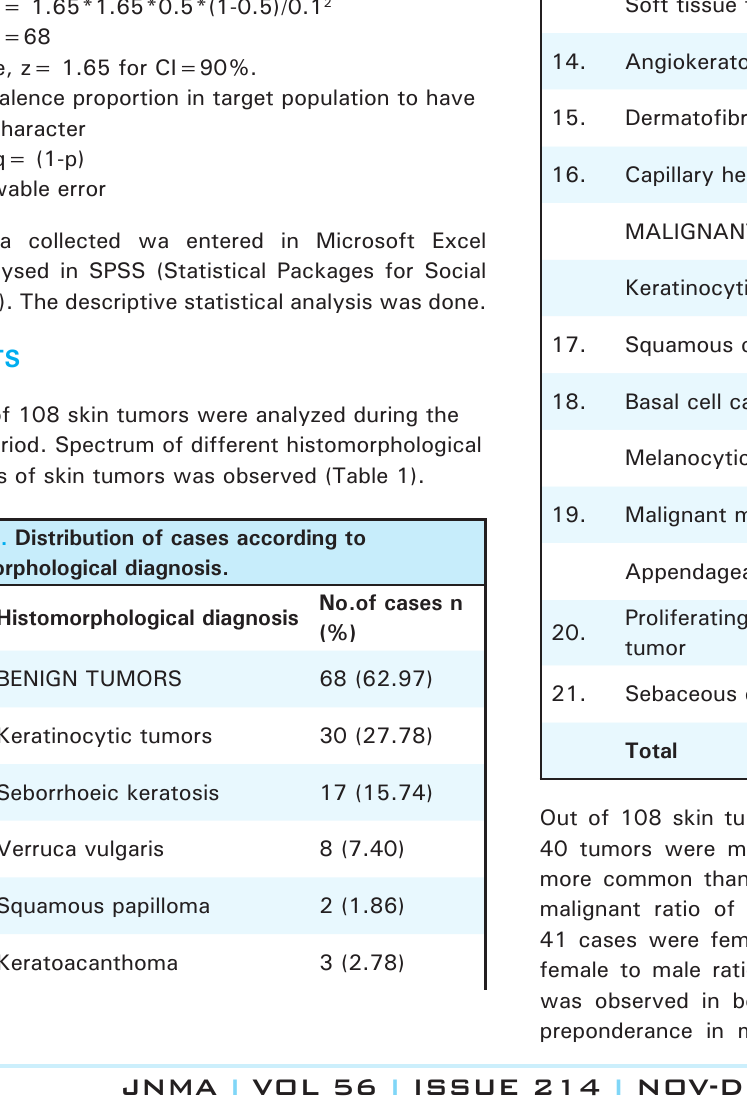
Free Full Text Articles are Available at www.jnma.com.np